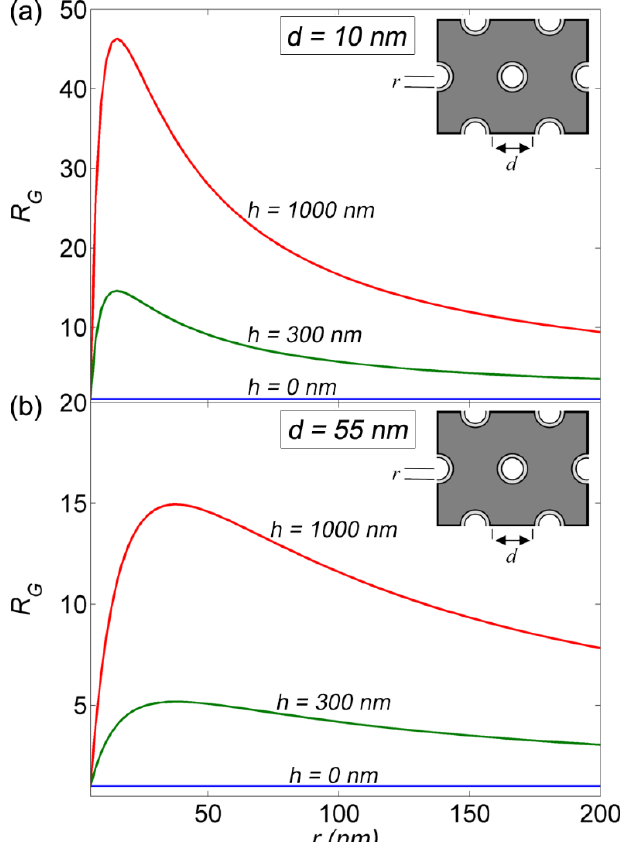
Figure 7. Evolution of the surface gain ( R G ) for hexagonally ordered nanoholes as a function of the radius ( r ) and for various nanorod heights ( h ). ( a ) presents the case of d = 10 nm and ( b ) presents the case of d = 55